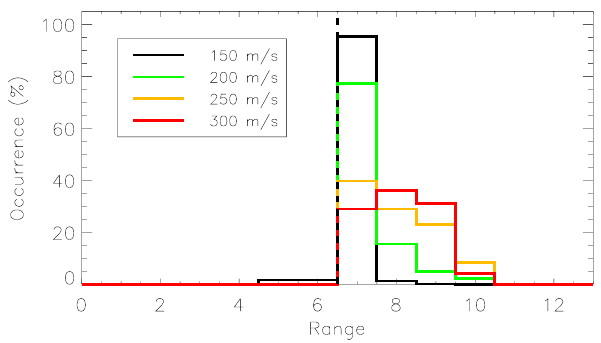
Fig. 8. The percentage occurrence of the location of the first range gate above the spectral width boundary within the spatially and tem- porally median filtered, simulated data set, as estimated by algo- rithm 3. The results are presented for the 4 different spectral width thresholds used in the analysis (150, 200, 250, and 300